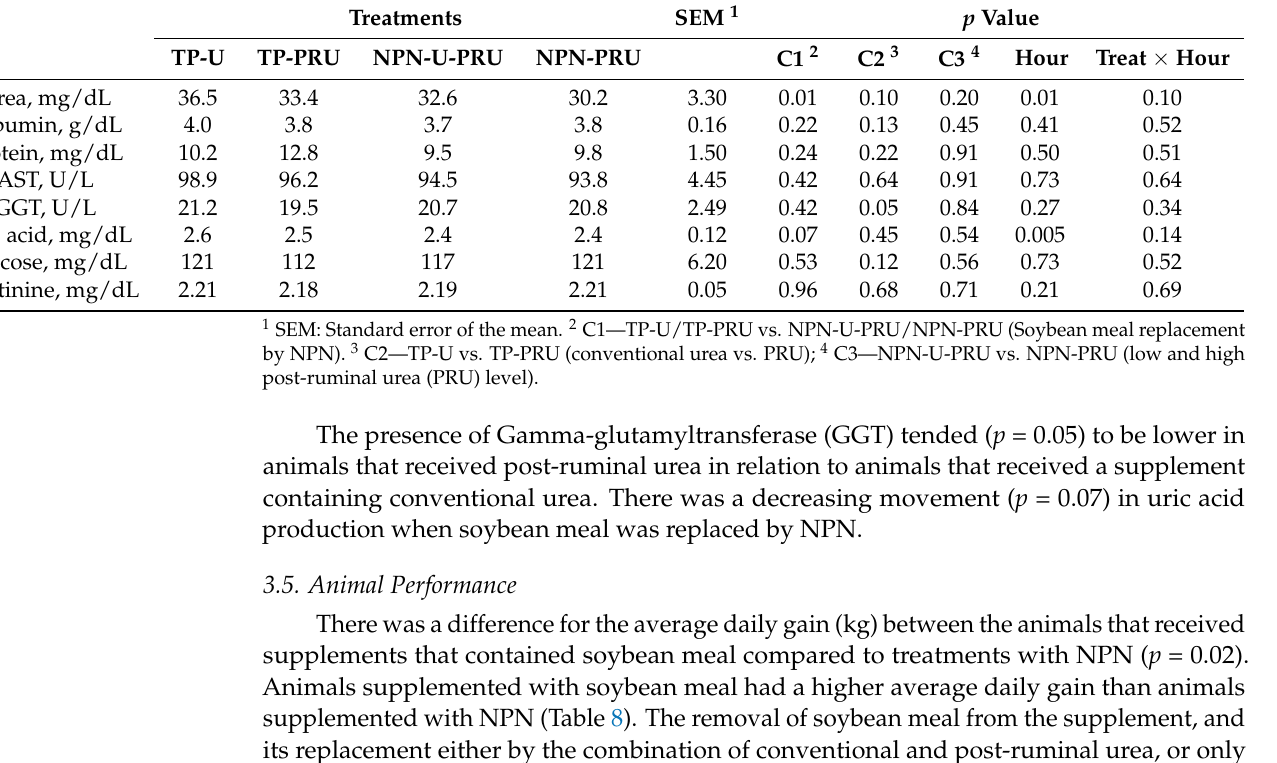
Table 7. Blood parameters of Nellore cattle receiving different types of supplementations in Urochloa brizantha cv. Marandu during the seasonal period. Treatments SEM 1